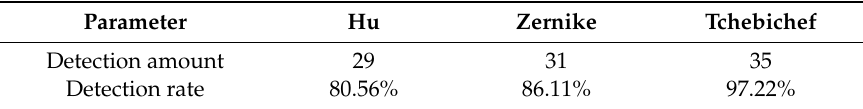
Table 5. Detection rate of the testing sample set in the third